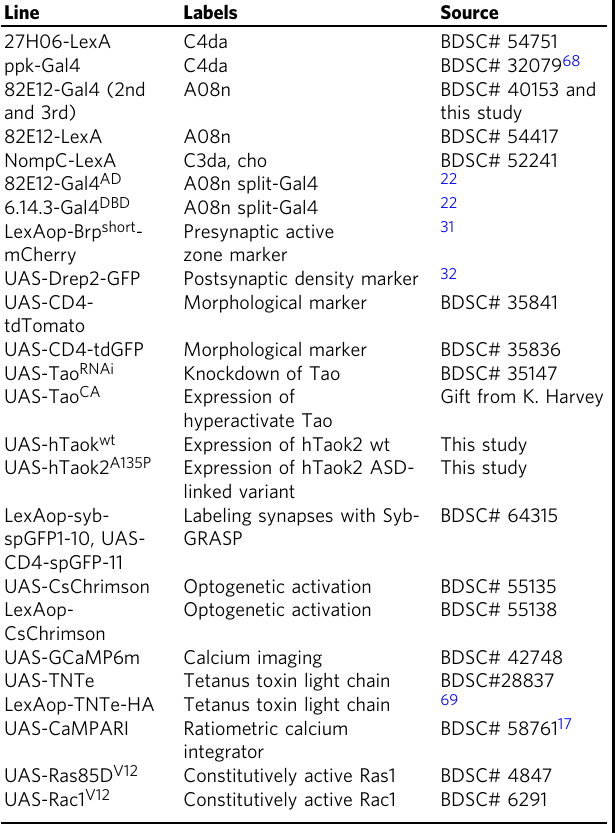
Table 1 Driver lines and transgenes used in this study